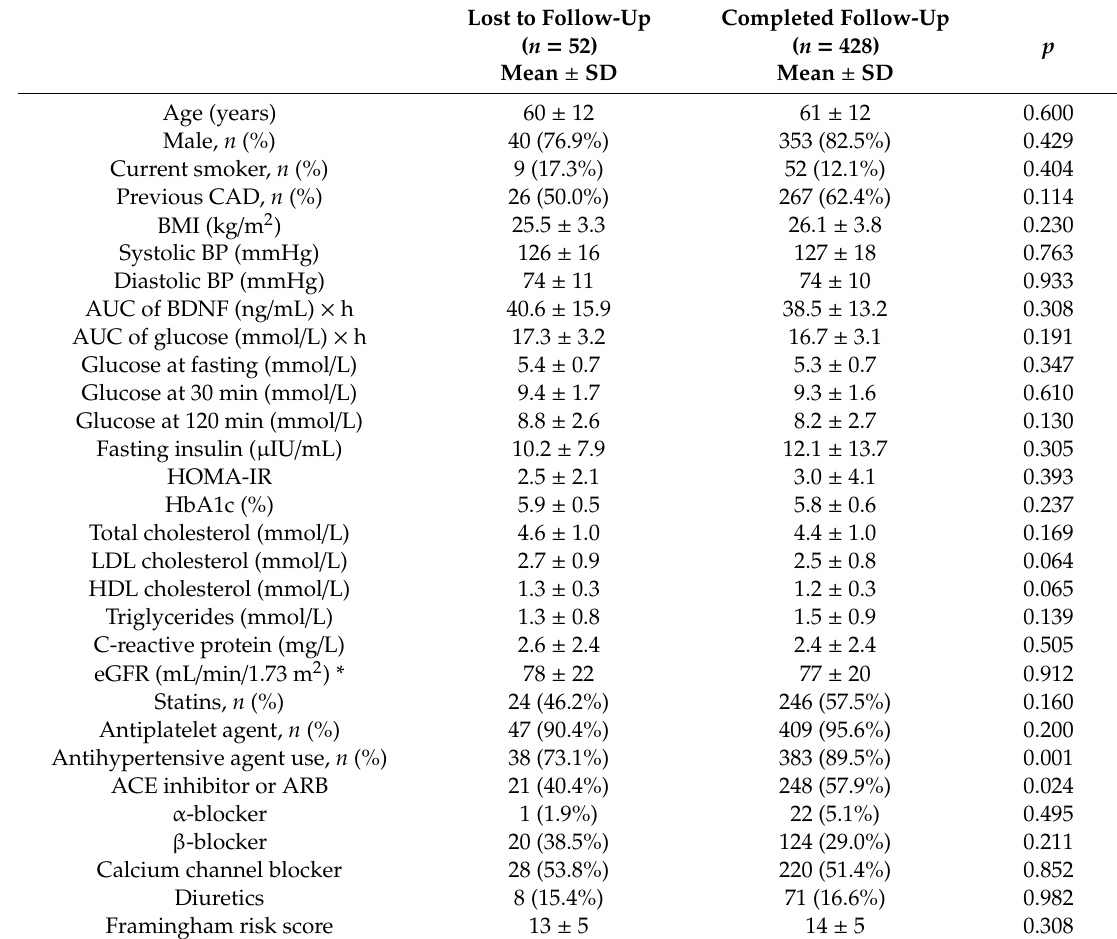
Completed Follow-Up Lost to Follow-Up ( n = 428) ( n = 52) Mean ± SD Mean ± SD